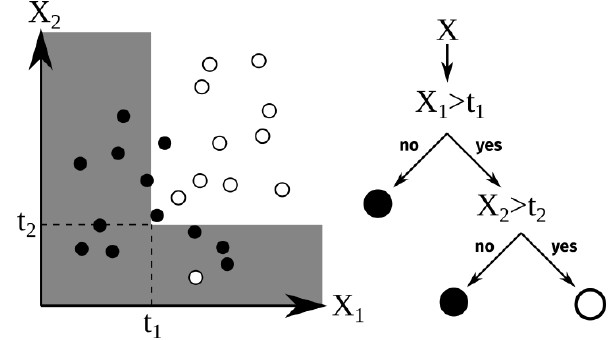
Figure 2. Illustration of binary classification with decision trees on two-dimensional artificial data.